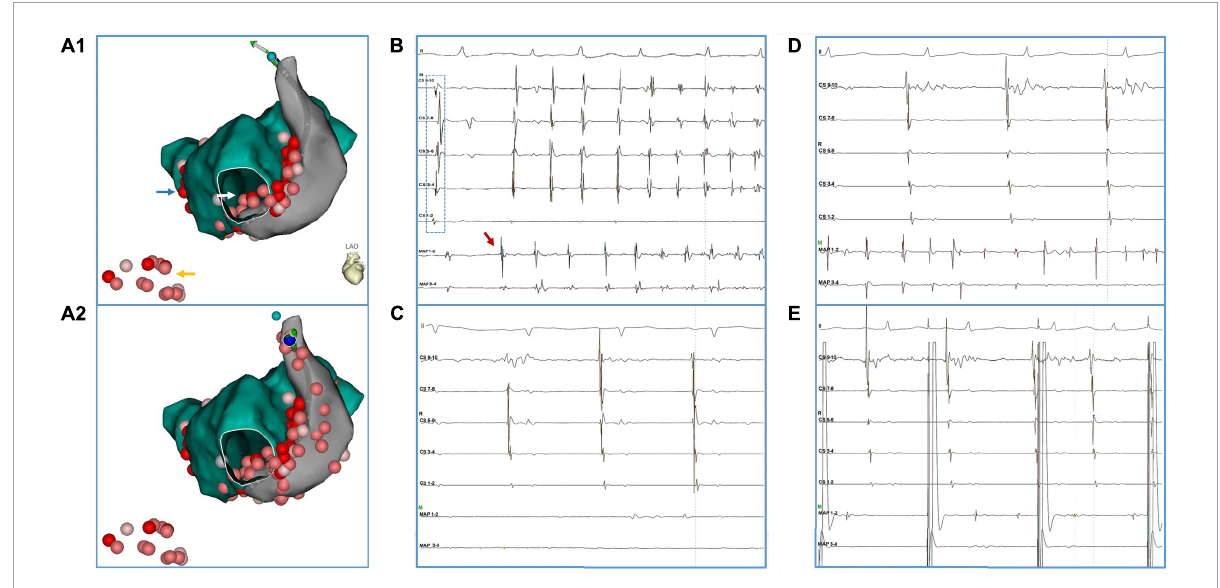
FIGURE1 A representative case of PLSVC isolation. The patient (#16) had AF recurrence after a previous ablation procedure in which only PVI was performed. (A1,A2) Blue arrow: touch up ablation at RPV. Yellow arrow: linear ablation at CTI. White arrow: CFAE at inferior LA. (B) Ectopy (red arrow) from distal PLSVC triggered an episode of AF. Notably, during the sinus beat, activation at the CS catheter presented a bracket-like sequence, which was probably caused by an earlier breakthrough at mid-PLSVC by LA-PLSVC connections. (C) After ablation at LA-PLSVC connections [Visitag points in PLSVC in (A1) ], AF terminated and sinus rhythm was restored. However, a mapping catheter positioned at the distal PLSVC could still record fibrillatory activities. (D) Further ablation at distal PLSVC (beyond the level of left superior PV) and ablation at the CS-PLSVC connections was conducted [Visitag points in PLSVC in (A2) ] which resulted in the elimination of local potential and loss of capture of LA during pacing from distal PLSVC (E) . (Abbreviations same as those in the main